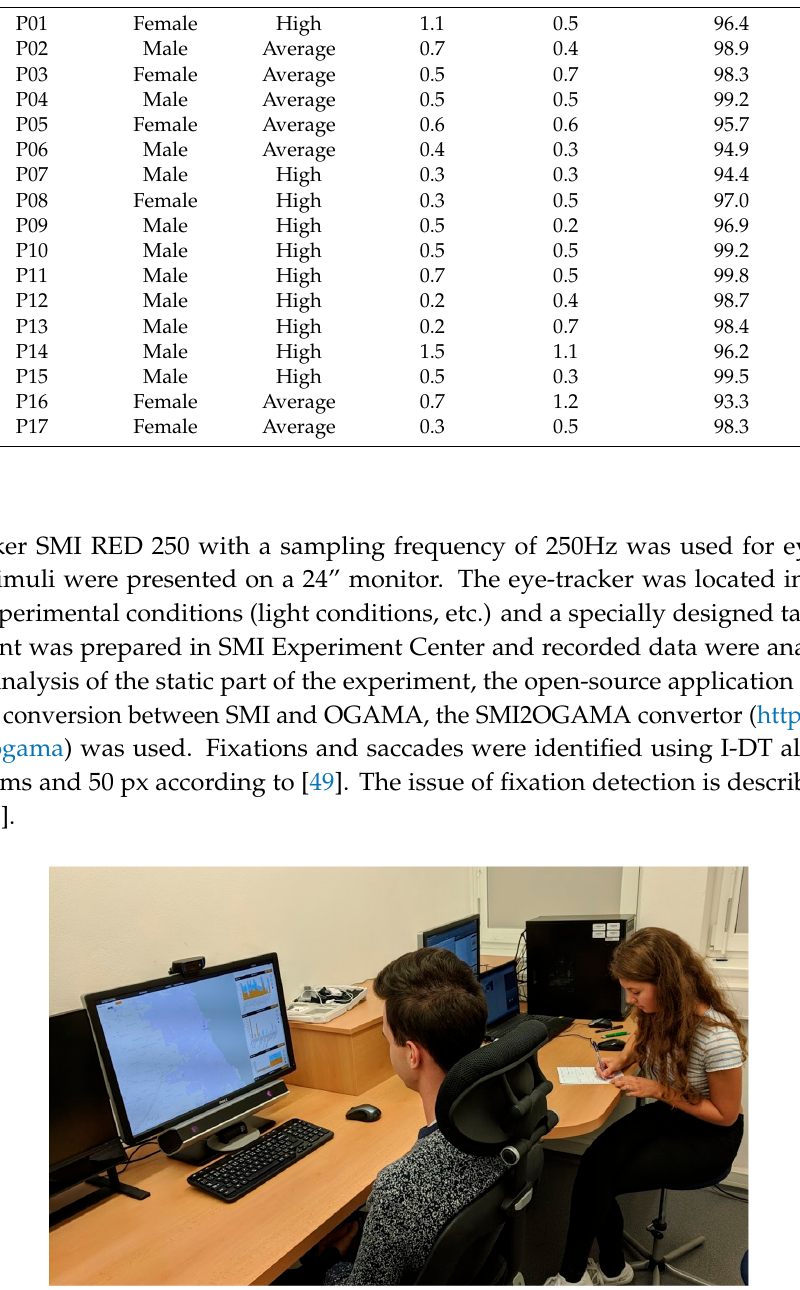
Table 1. Participants of the study.